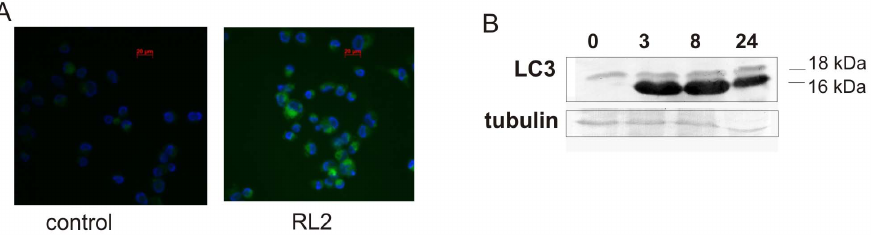
Figure 5. RL2 treatment induces autophagic changes in MDA-MB-231 cells. A . Cells were treated with RL2 (0.2 mg/mL) or non-treated (control) for 8 h and fixed with 4% paraformaldehyde followed by immunostaining with anti-LC3A/B primary and FITC-conjugated secondary antibody. Images are representative of two independent experiments. B . MDA-MB-231 cells were treated with RL2 (0.2 mg/mL) for various time points (0, 2, 6 and 24 h). Total lysates were prepared and subjected to Western blot analysis. Shown are representative blots of five independent experiments.